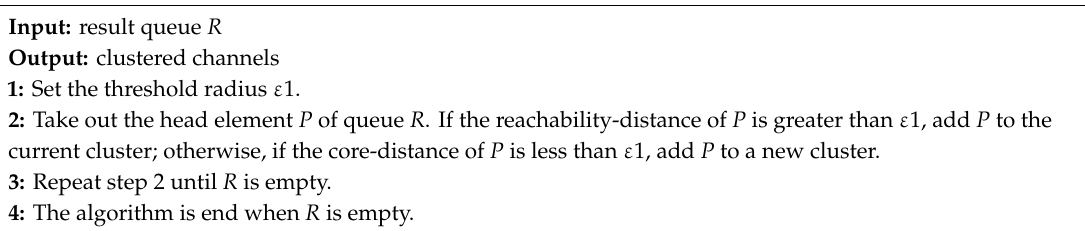
Algorithm 2 Obtaining the clustering